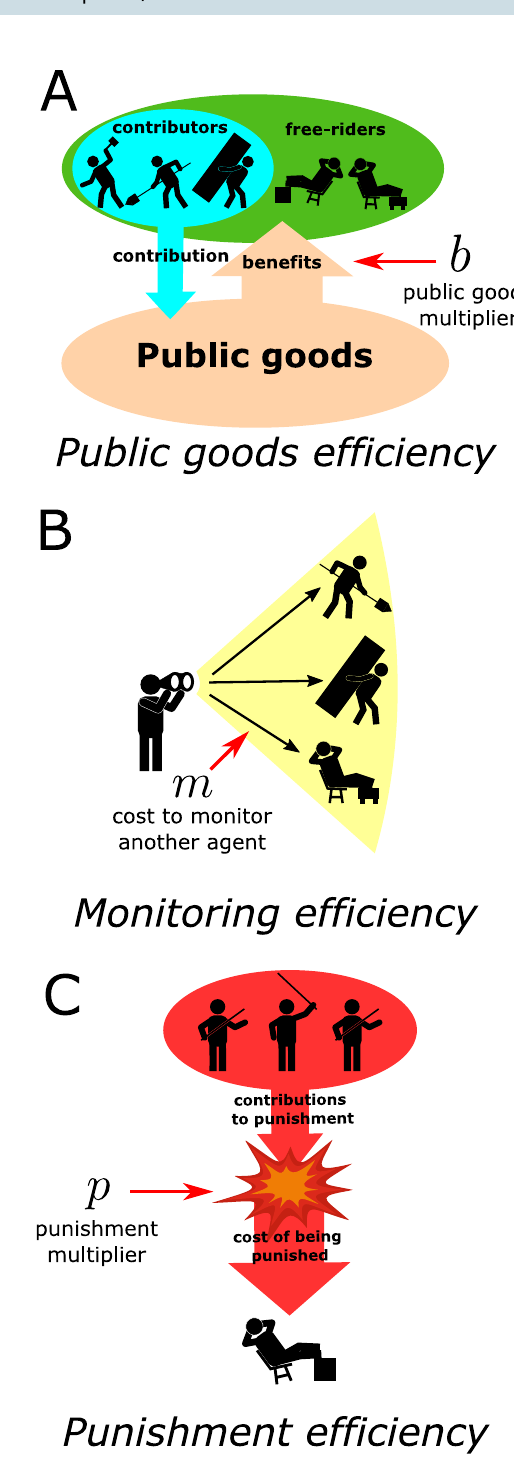
Figure 2. The three efficiencies that determine optimal network structure. An individual’s contribution to a public good is multiplied by the public goods efficiency, b , and the result is distributed equally to other group members. Monitoring efficiency, m , is the cost for one individual to effectively monitor another. An individual’s contribution to punishment is multiplied by the punishment efficiency, p , and the result is subtracted from the punished individuals’